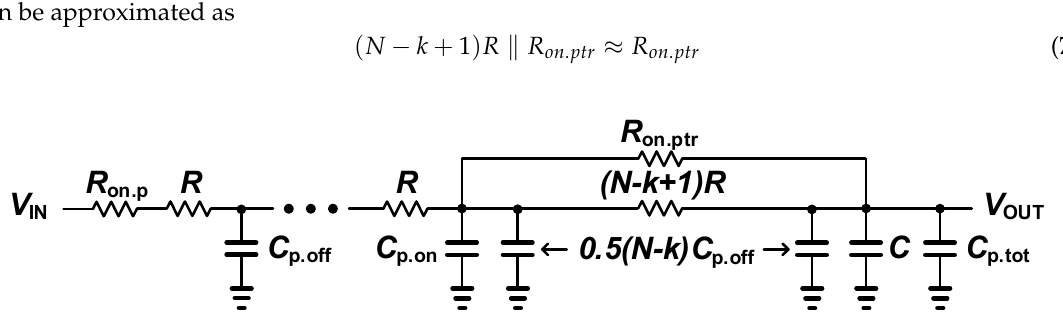
Figure 6. Equivalent RC network model of proposed delay cell.